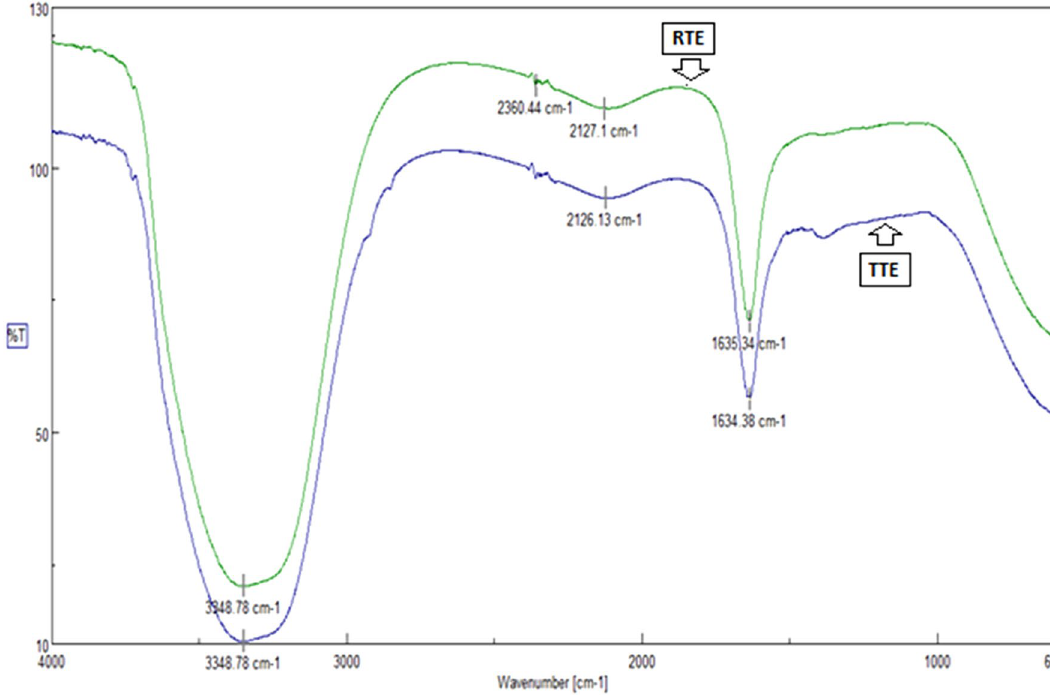
Figure 1. FT-IR spectral analyses of raw and treated textile effluent.